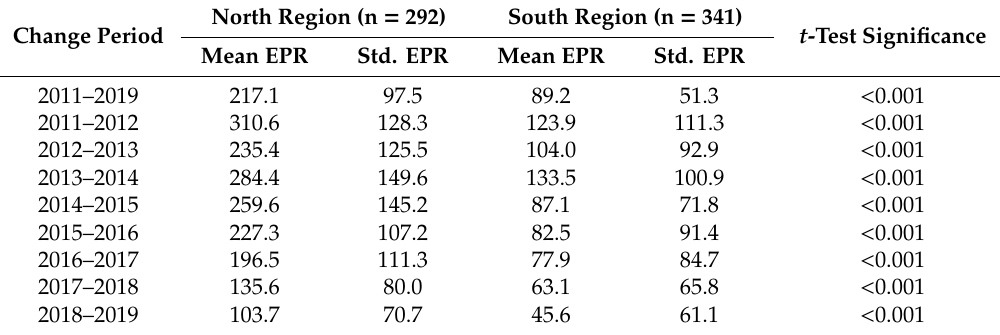
Table 7. Shoreline erosion by region, End Point Rate in m/y.